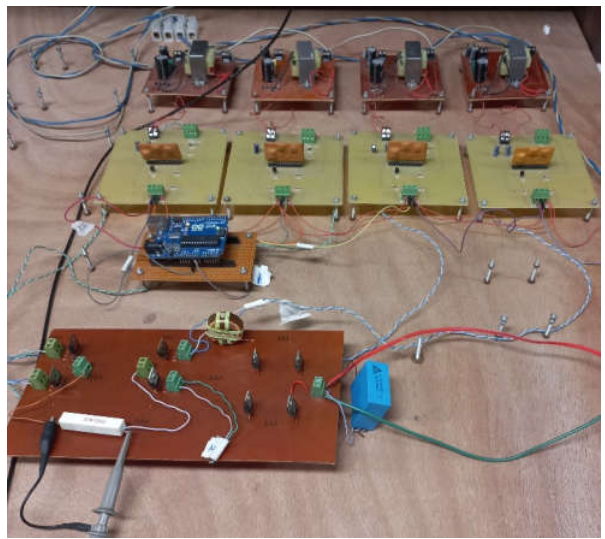
Figure 9. Practical setup.